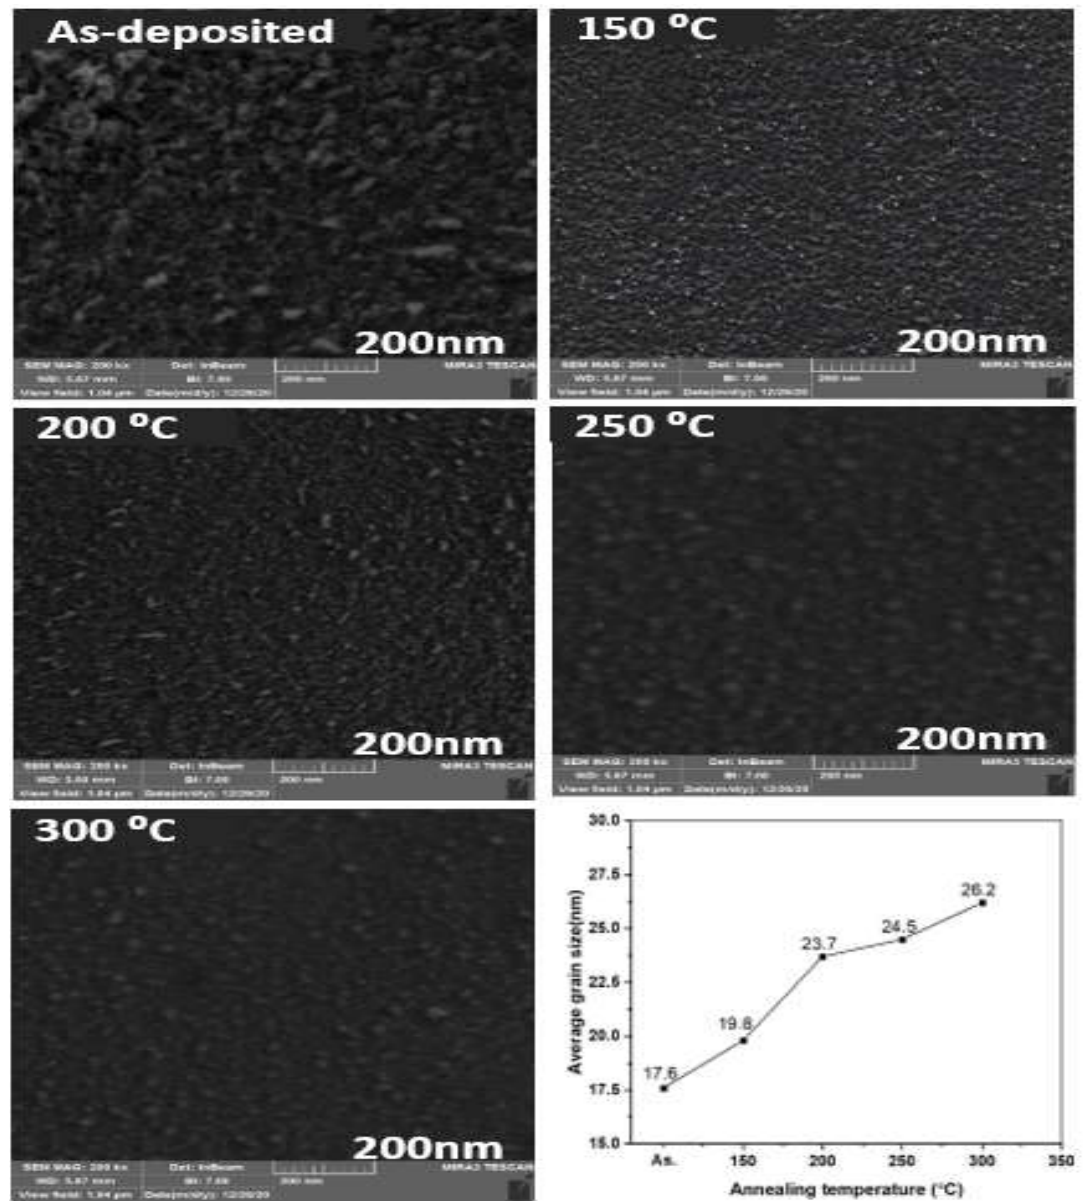
Figure 3: SEM images of the ZnO thin film before and after treatment by the OTA